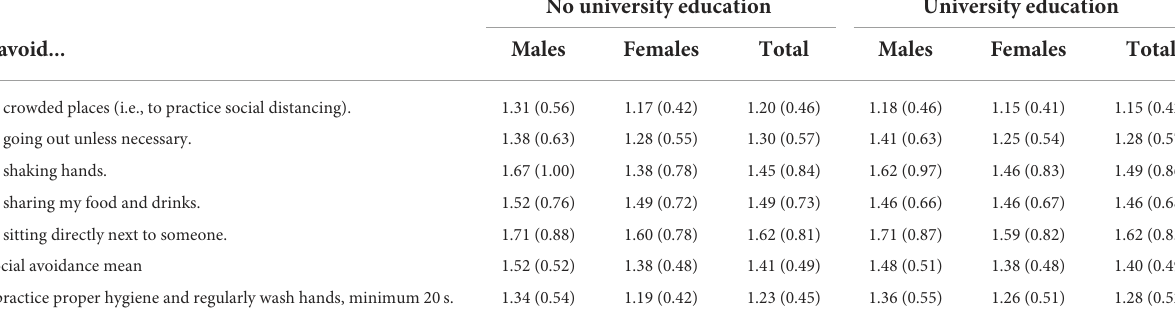
No university education